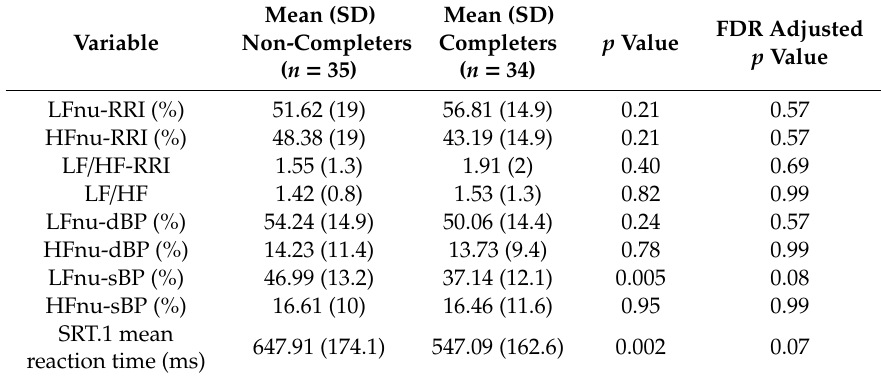
Table 3. Comparison of completers vs. non-completers in autonomic nervous system and cognitive functioning before SEP.